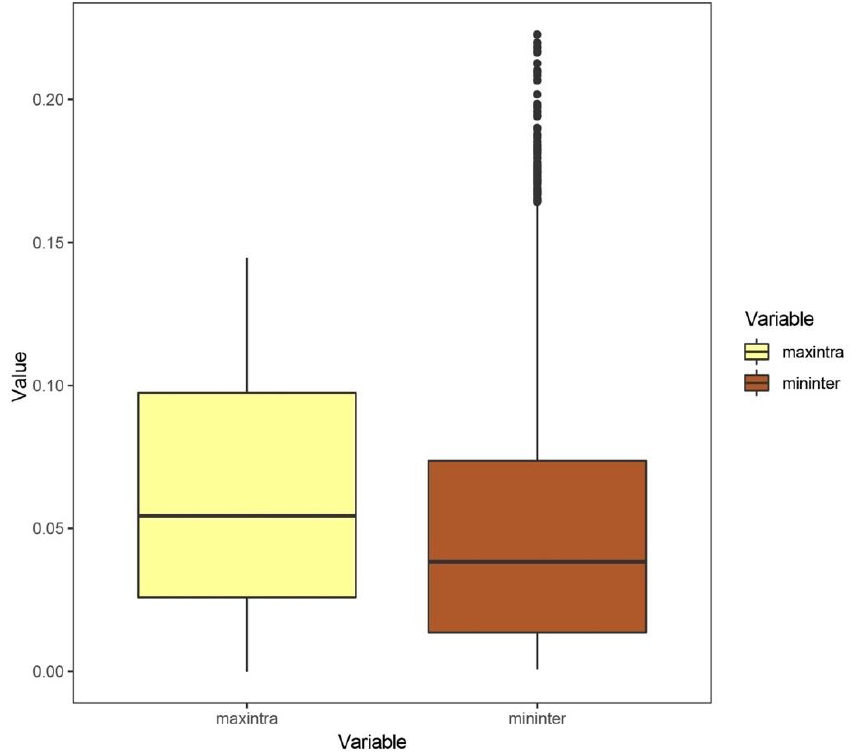
Figure 2. Intraspecific and interspecific genetic distances of 4288 genera. maxintra: the maximum intraspecific genetic distance of congeneric species; mininter: the minimum interspecific genetic distance of congeneric species.